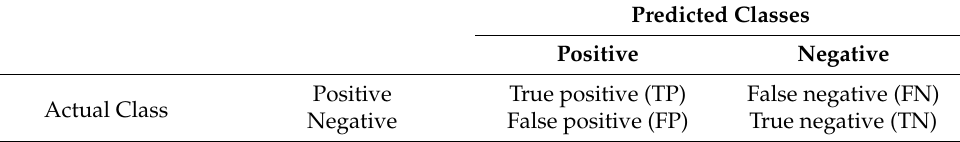
Table 5. Confusion